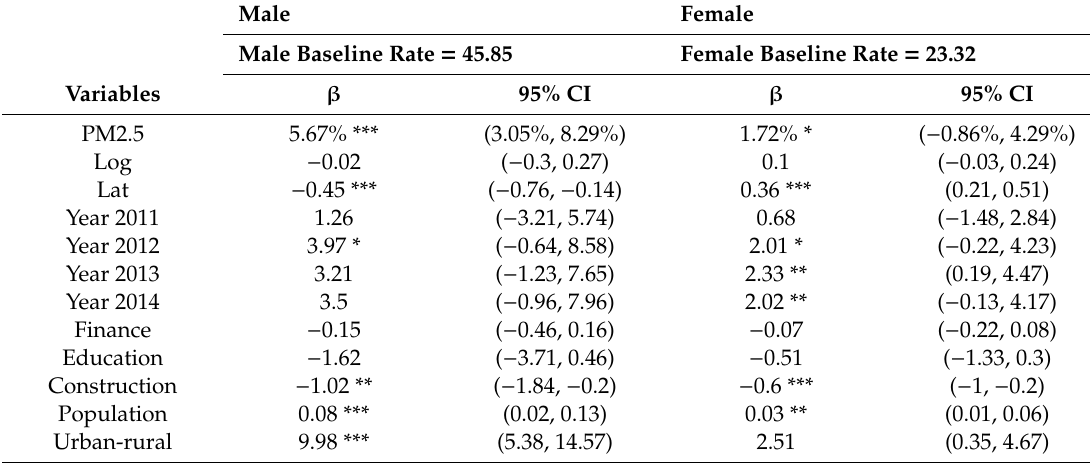
Table 6. Sensitivity analysis using 5 year consecutive data from 91 counties for males and females. Male Female Male Baseline Rate = 45.85 Female Baseline Rate = 23.32